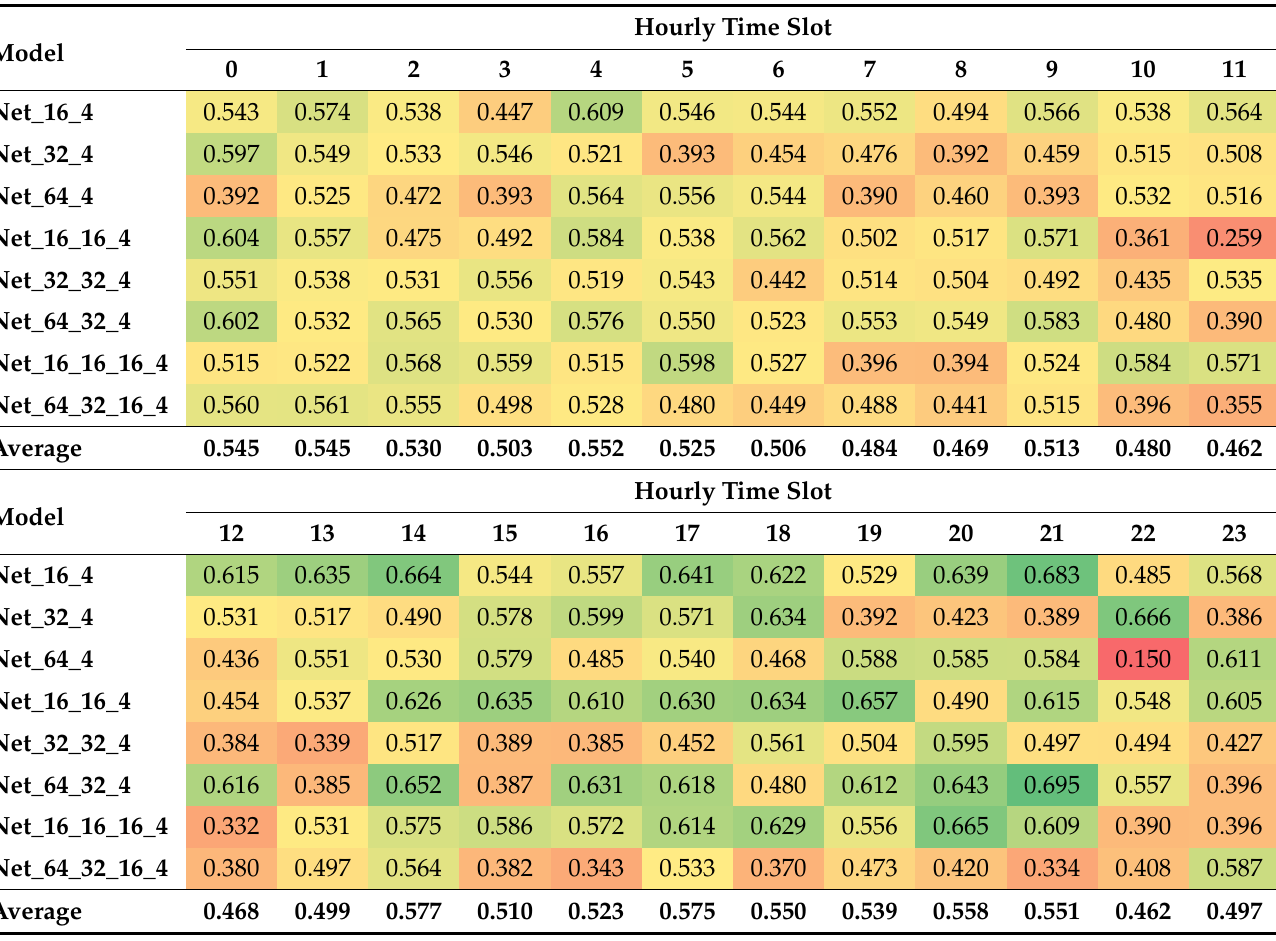
Table 3. Accuracy of the trained models over the 24-h time slot datasets. Different colors represent an accuracy heat-map to visually identify